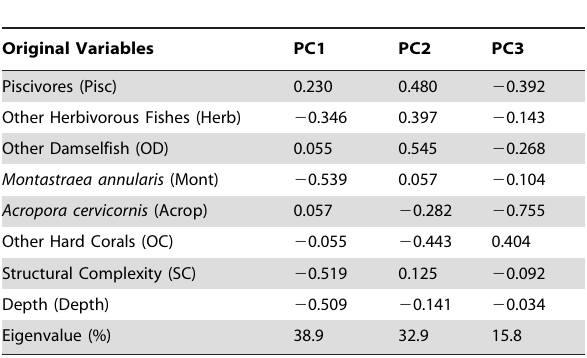
Table 2. Eigenvectors and eigenvalues for the principal component analysis of eight independent variables collected at the 12